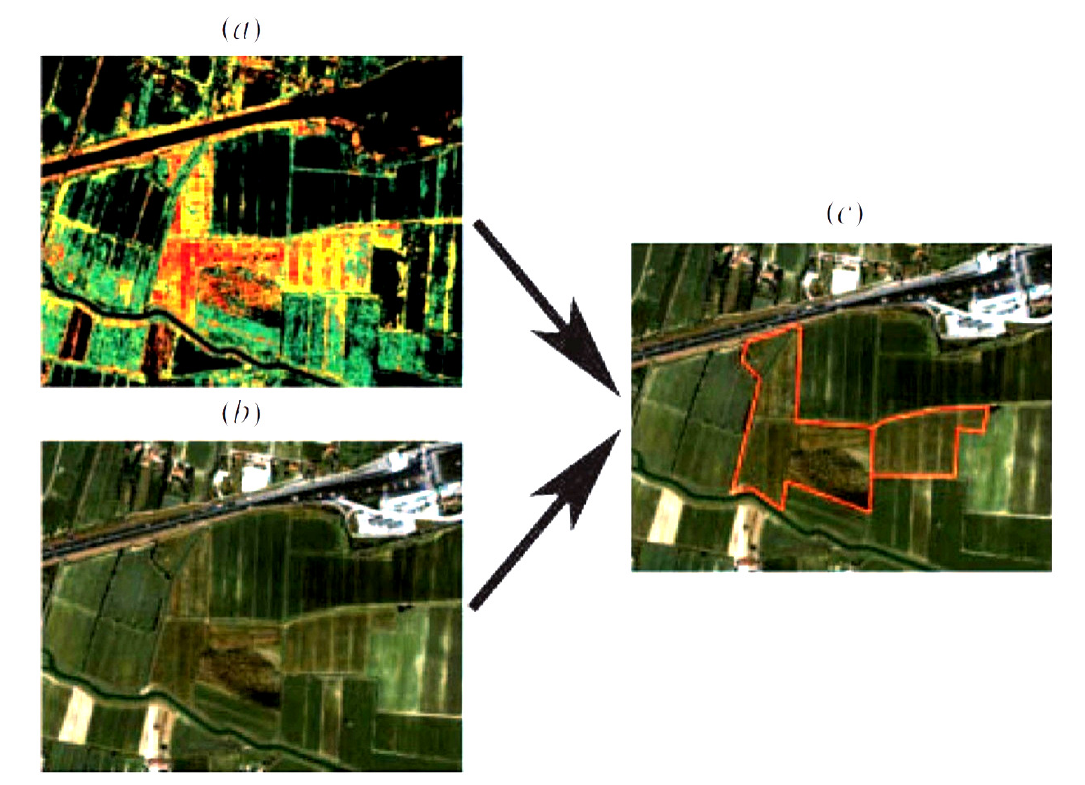
Figure 6. Methodology for the identification and mapping of potential uncontrolled hazardous waste sites from multispectral imagery; (a) maximum likelihood classification result showing the most stressed areas in red and the least stressed areas in green, with black showing background unclassified area; (b) the Ikonos Image in standard color combination, used for comparison and (c) mapping of polygon of interest on geo-referenced Ikonos image. From Silvestri and Omri, 2008